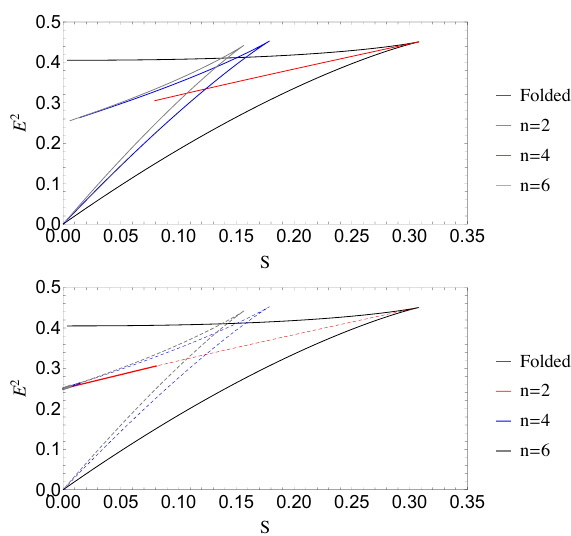
Figure 9 . Regge trajectories of outward spike solutions (the upper panel) and rounded spike solutions (the lower panel) for the winding number N = 1 . The spin S and the energy E are plotted in units of R 2 /α 0 and R/α 0 , respectively, as before. For comparison, we also illustrate the Regge trajectory of one-folded strings. The dotted curves in the lower panel are the Regge trajectories for outward spikes, which are smoothly connected with those for rounded